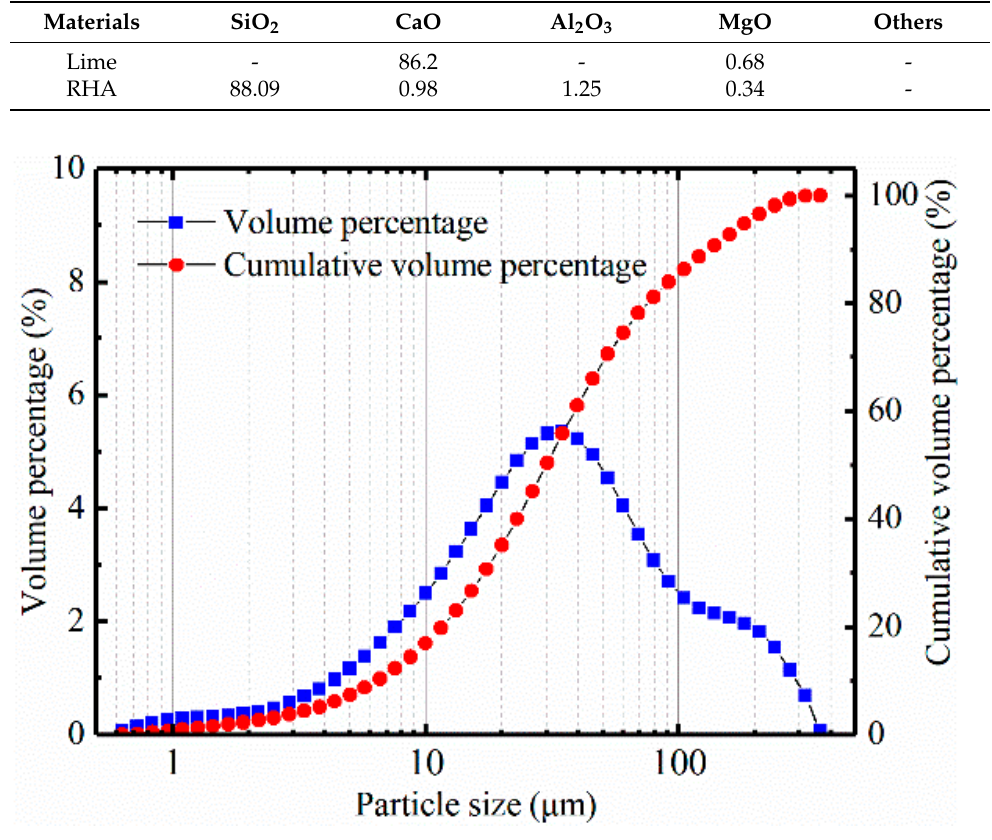
Figure 2. Particle size distribution of RHA.